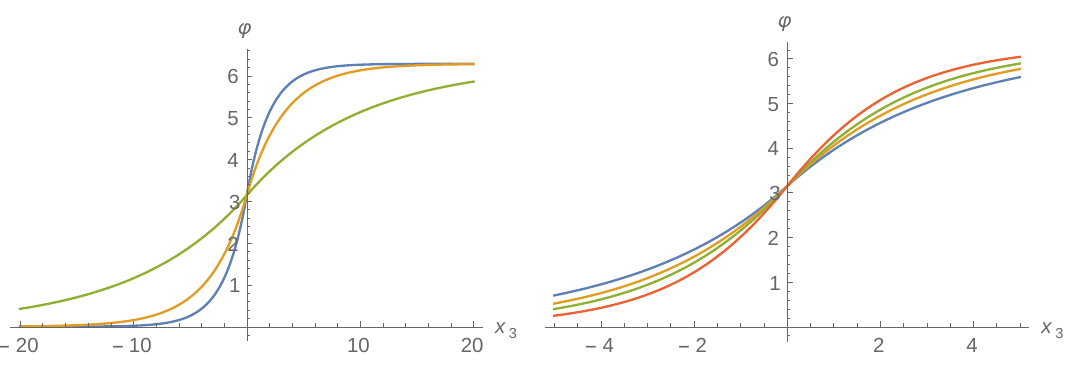
−√ 2 η 0 /f for m = 0 . 1 , 0 . 3 , 0 . 5 (green, yellow and blue π WV /M KK = 0 . 3 and m 2 = 0 , 0 . 05 , 0 . 1 , 0 . 2 (blue, green, /M 2 WV /M KK π KK